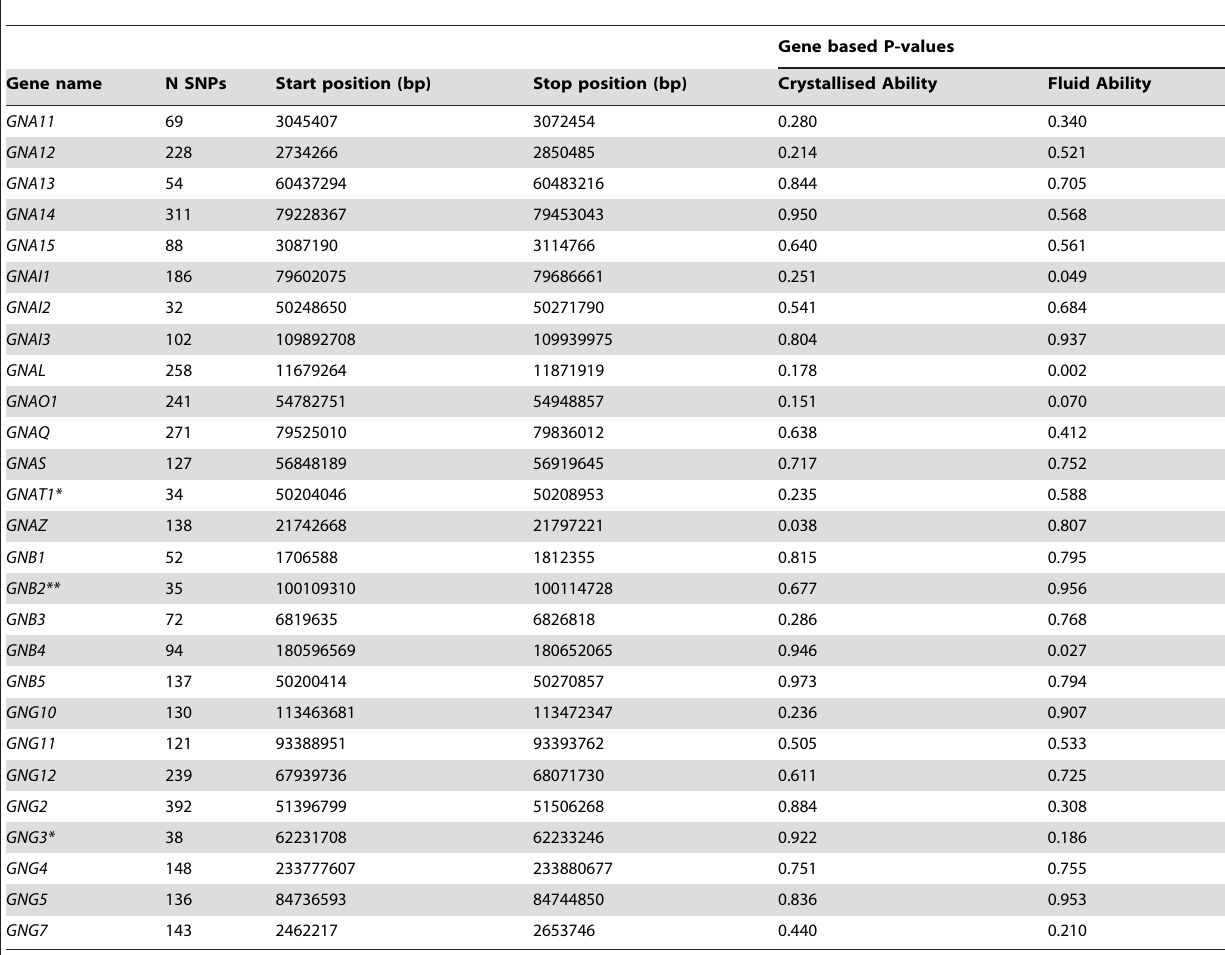
Table 2. Gene based analysis results for Crystallised and fluid cognitive ability.